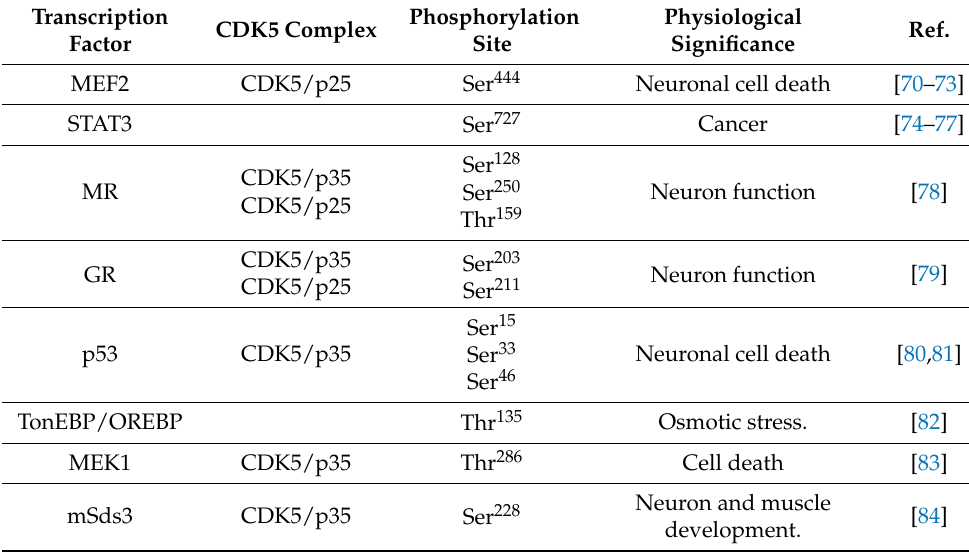
Table 3. The modulation of transcription factors by